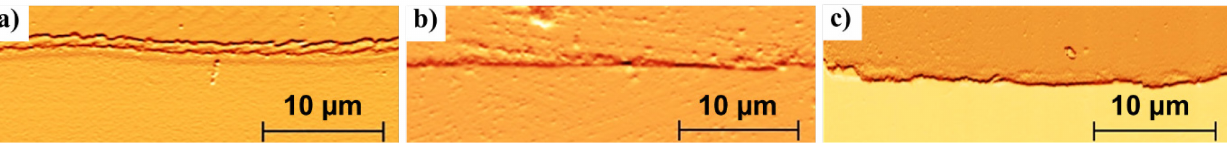
Figure 3. Edge quality of an IDES finger controlled by colour contrasted atomic force microscopic images. ( a ) ITO on glass; ( b ) platinum on glass; ( c ) photolithographically (photo mask) produced chip (GeSiM®).